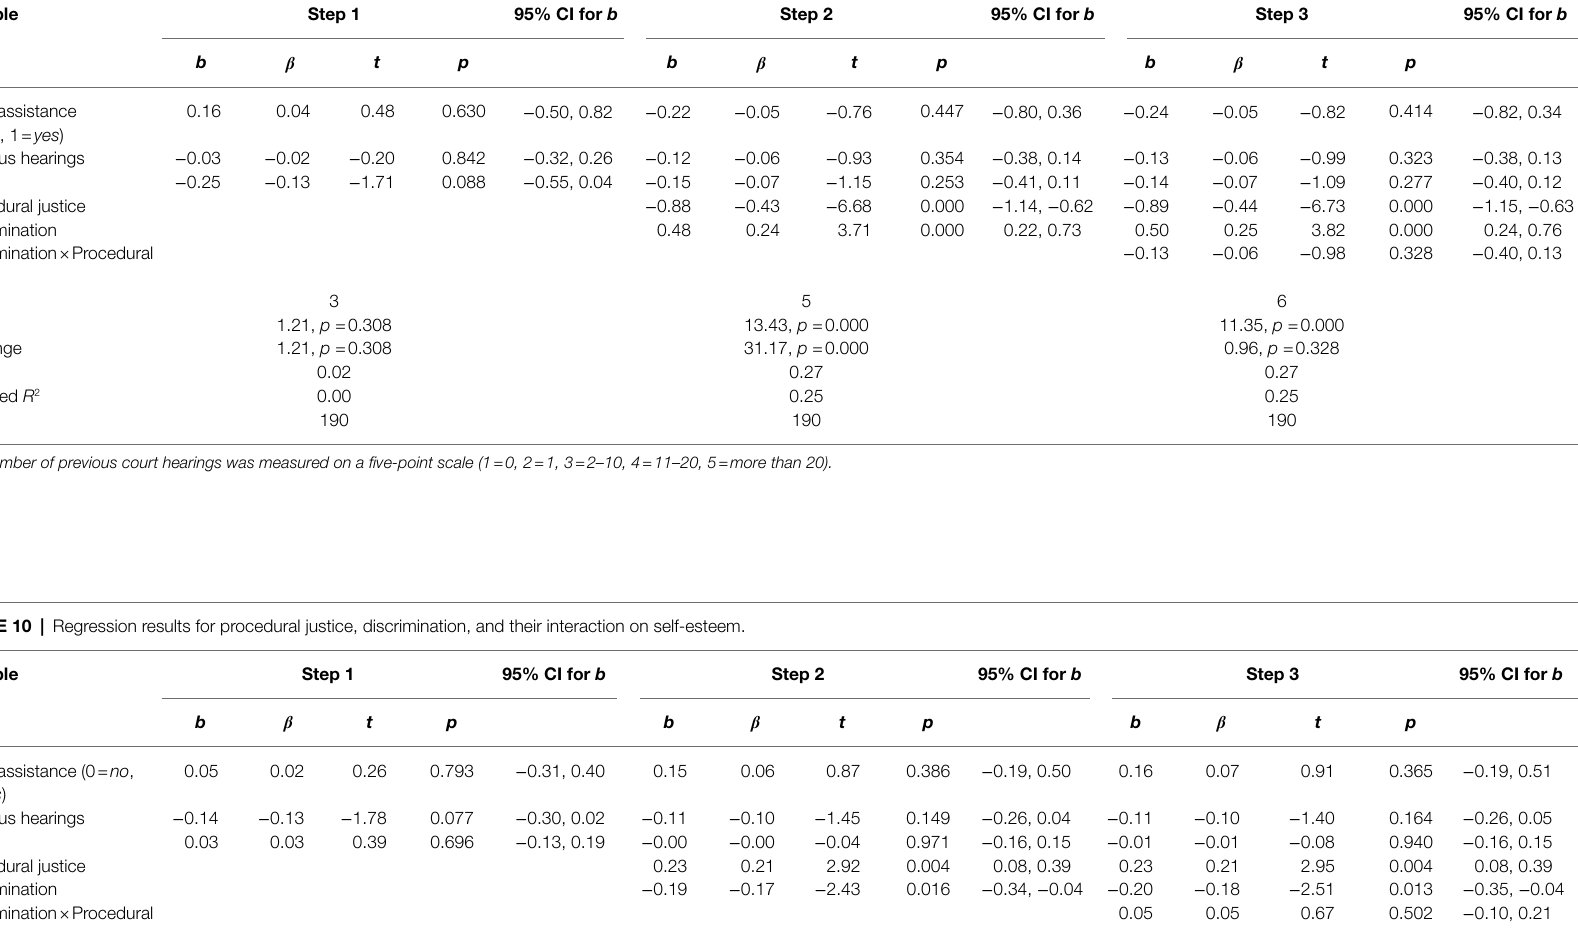
TABLE 9 | Regression results for procedural justice, discrimination, and their interaction on protest intentions.